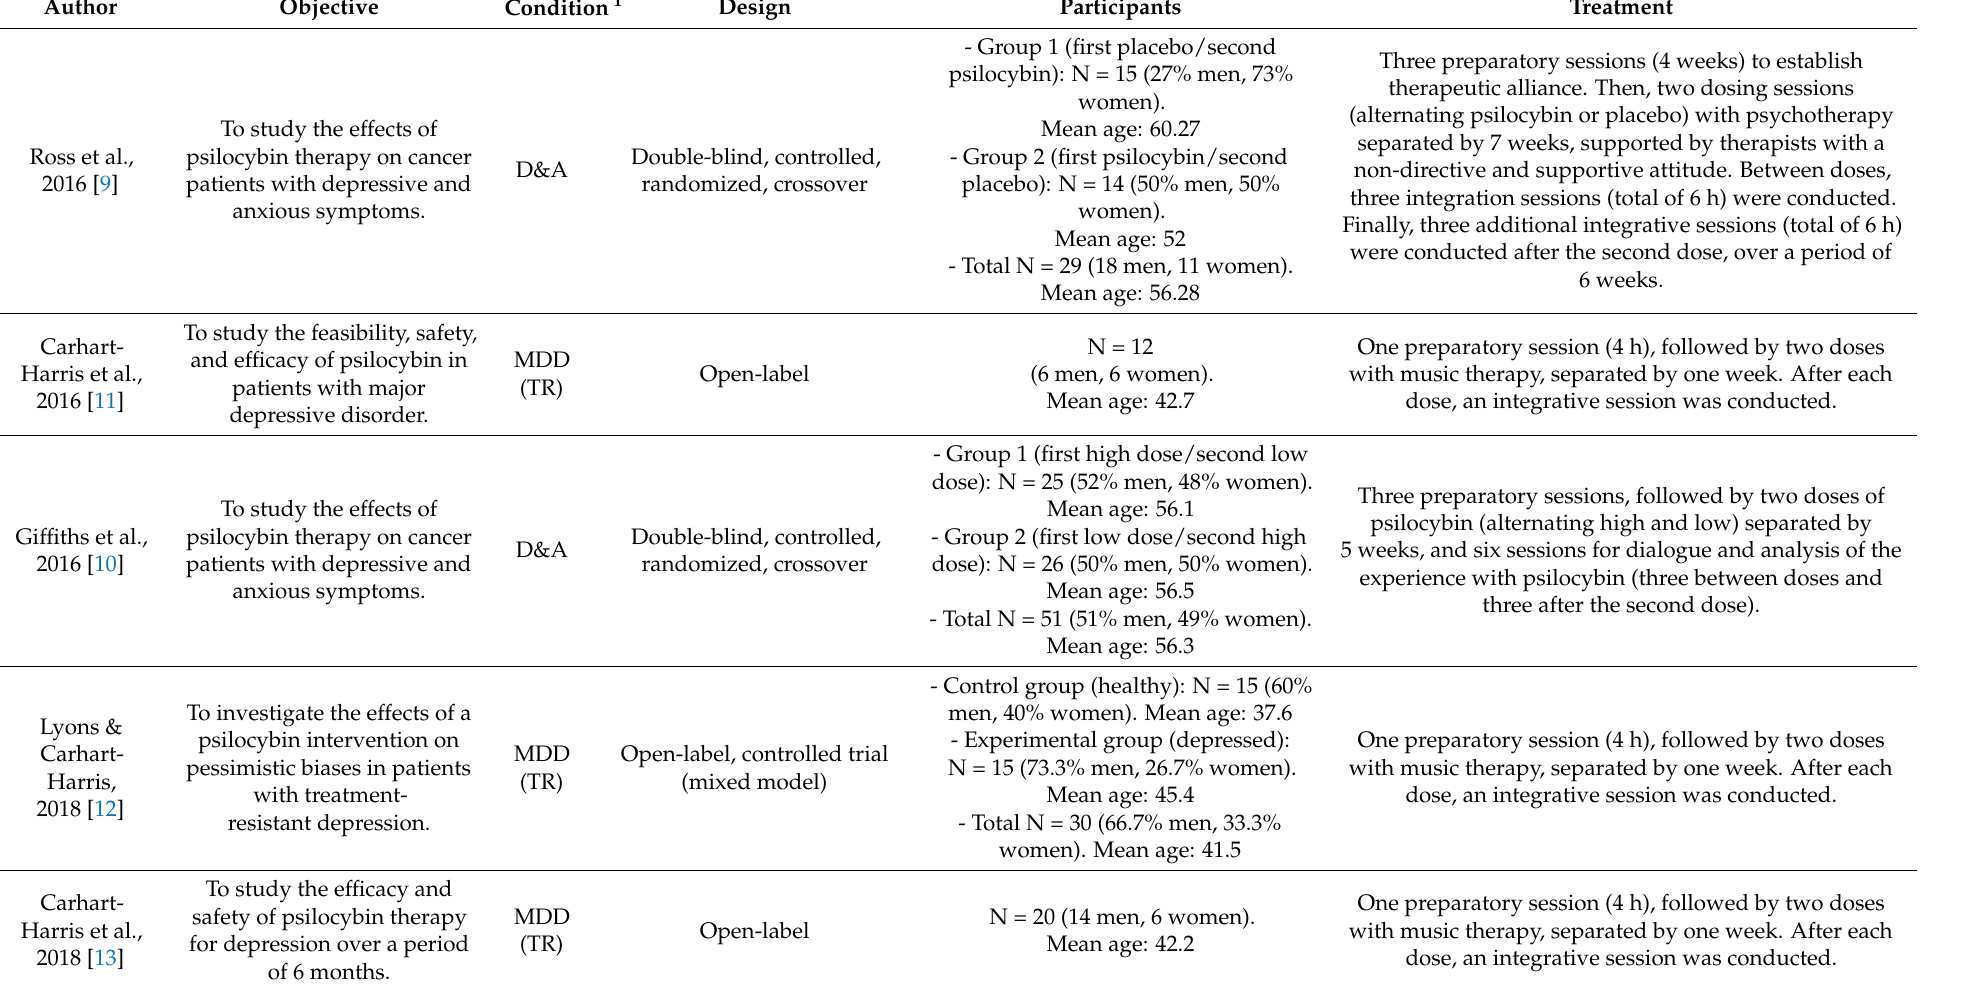
Table 1. Authors, objectives, conditions, designs, participants, and treatments of the